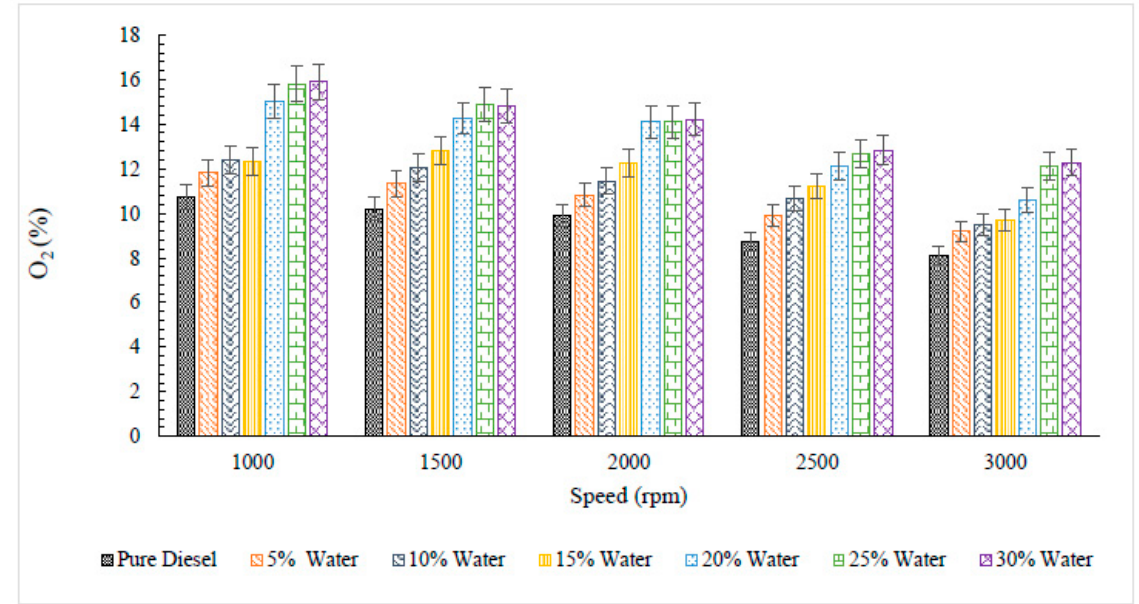
Figure 6. Effect of water-in-diesel emulsion fuel on oxygen dioxide emitted from a diesel engine at different engine speed.